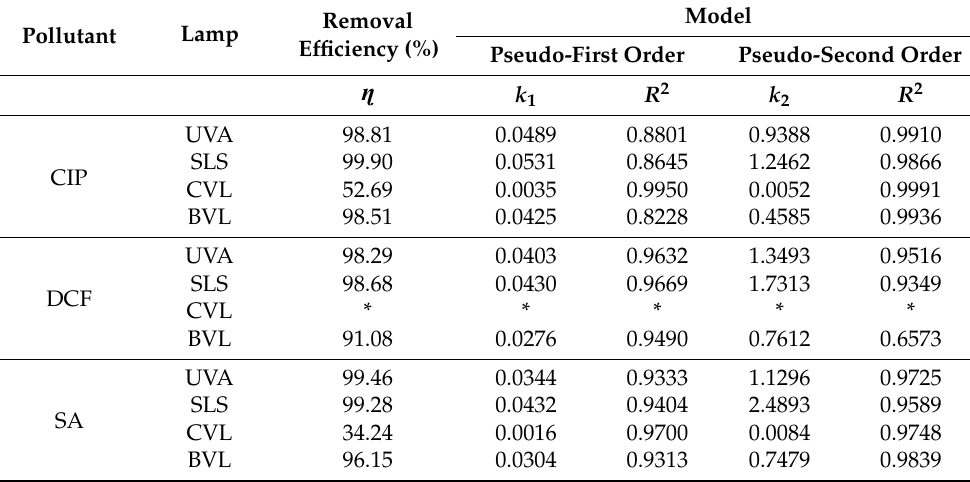
Table 5. Pseudo-first-order, pseudo-second-order kinetic parameters, and CIP, DCF, and SA removal Table 4. Pseudo-first-order and pseudo-second-order kinetic parameters and efficiencies of CIP re- efficiencies by N/TiO 2 /rGO 0.25 wt.% photocatalyst under UVA, solar light simulator (SLS), cold moval by N/TiO 2 , TiO 2 P25, and N/TiO 2 /rGO materials under UVA, solar light simulator (SLS), and visible light (CVL), and blue visible light (BVL). cold visible light (CVL). Lamp k 1 R 2